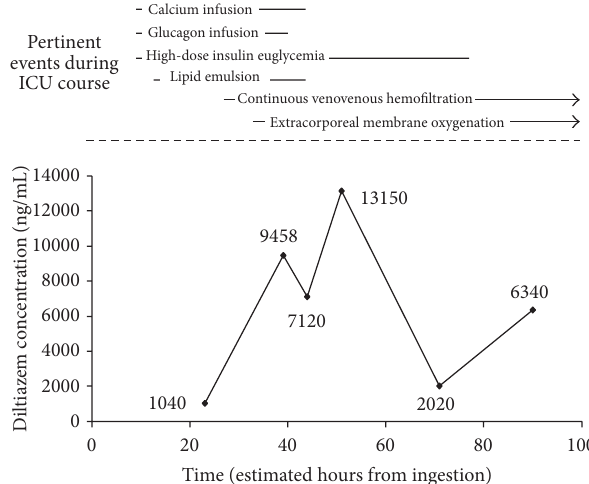
Figure 1: Diltiazem serum concentrations and concurrent interven- tions during ICU course according to suspected time from ingestion based on patient